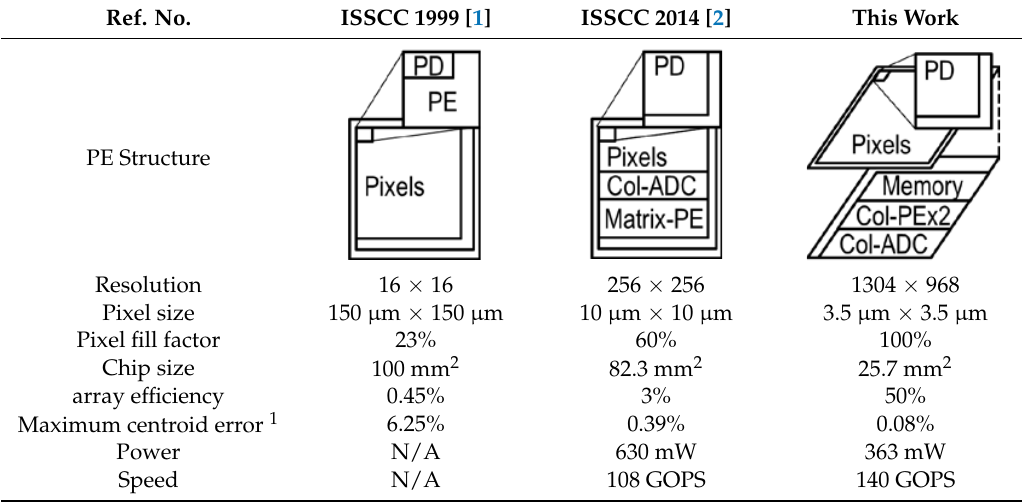
Table 4. Comparison of vision chips.